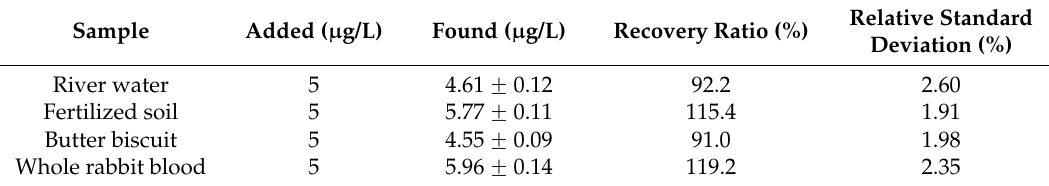
Table 9. Determination of the simulated ricin specimens by conventional double-antibody sandwich ELISA ( n =